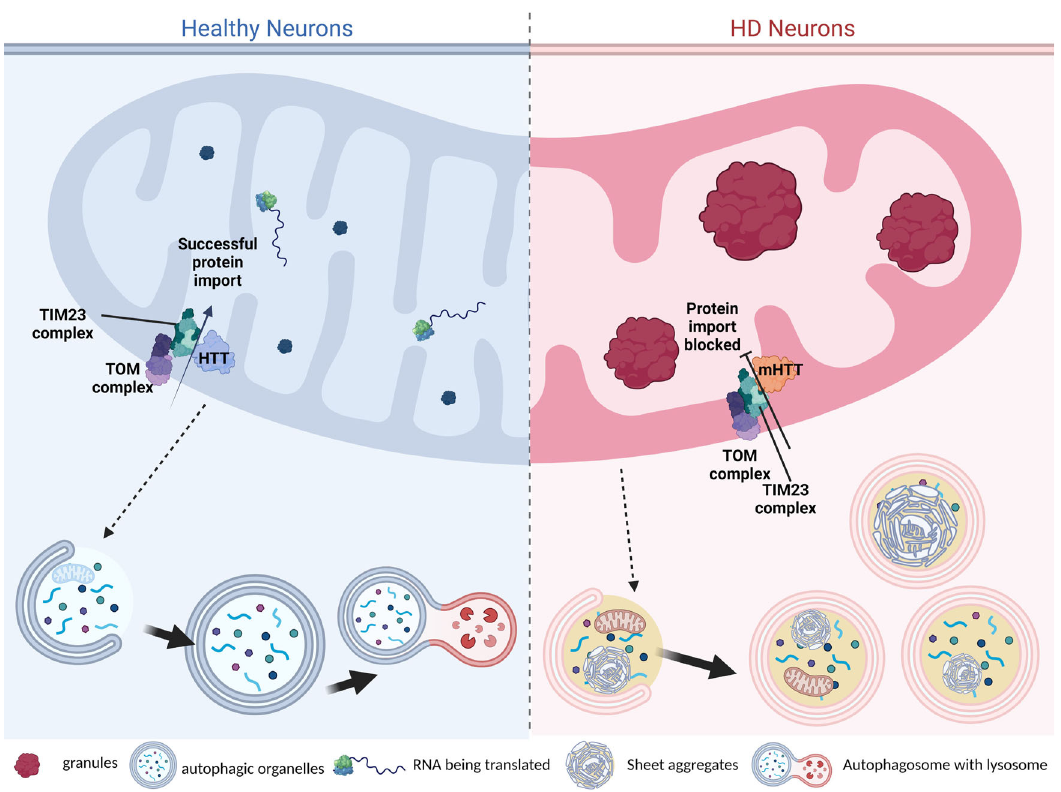
Fig. 10 | Proposed mechanism of aberrant mitochondrial structures and sheet aggregatesinautophagicorganelles. Ourworkherehighlightsthe accumulation of enlarged mitochondrial granules in four human and two mouse HD neuronal models, which we hypothesize could result from disrupted protein import due to mHTT ’ s abnormal interaction with the TIM23 complex 47 . Additionally, our mass spectrometry data suggest that RNA binding may be disrupted within HD mito- chondria, which may lead to excess RNA molecules within the mitochondrial matrix. There is cross-talk between mitochondria, autophagosomes, and